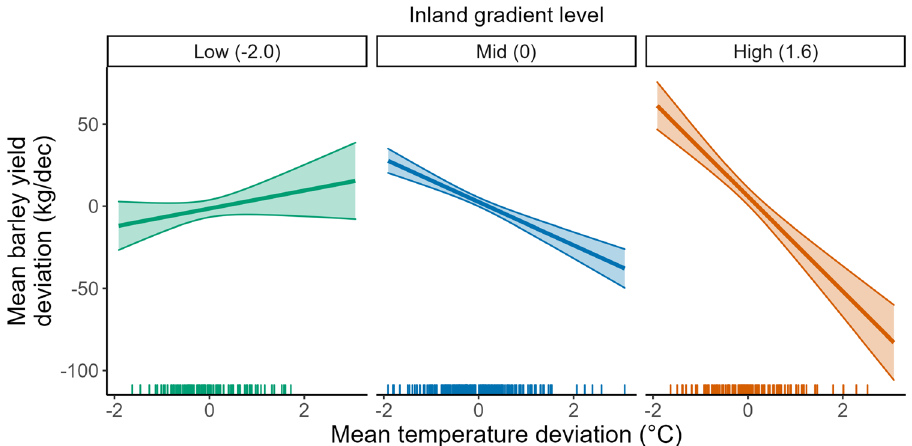
Figure 3. Predicted relationship between mean temperature deviation and mean barley yield deviation for varying levels of the Inland gradient. The three graphs are drawn at the 10th, 50th and 90th percentile for the Inland gradient. Higher values for this gradient are associated with distance from the coast and cooler winter temperatures. Regression lines show the predicted yield deviation from the LMM when all other predictors are held constant at mean values. Shaded areas are ± 1